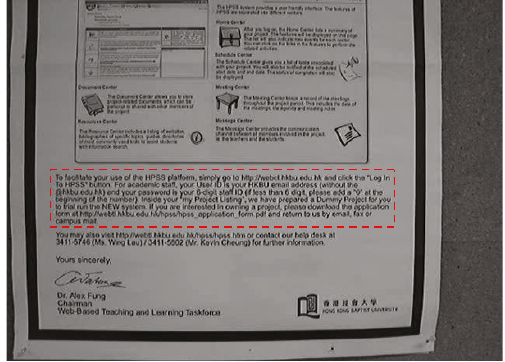
Figure 16: One 640 × 480 frame in the “bulletin” video. The region boxed in dashed is the